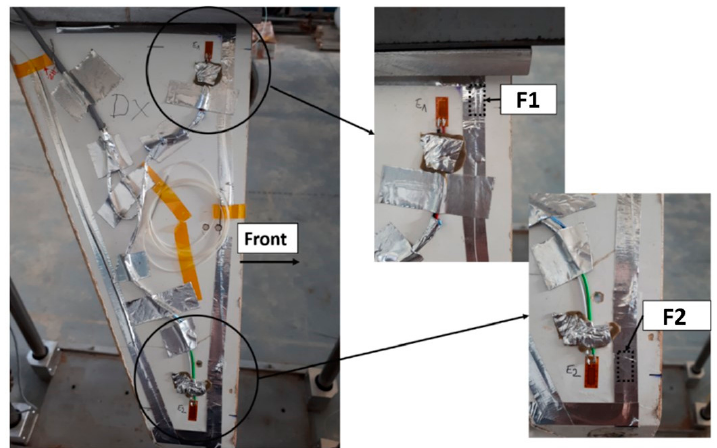
Figure 8. Top face of the right leg of the landing gear equipped with FBG and SG sensors.